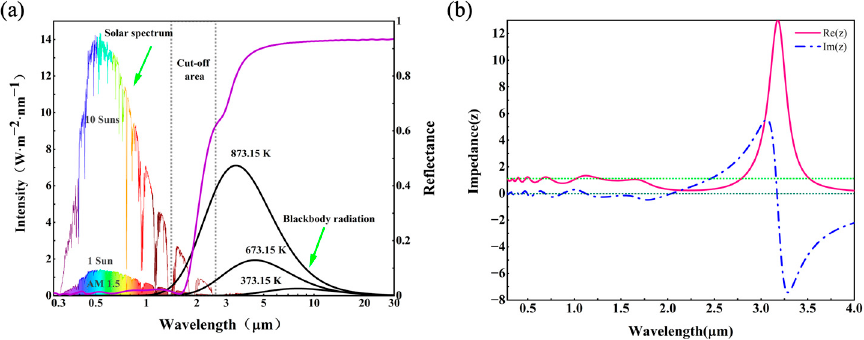
Figure 2. ( a ) Solar spectrum (AM 1.5) at 1, 10 optical concentrations, black body radiation spectrum (black line) at 373.15 K, 673.15 K, 873.15 K interspersed with reflection spectrum (purple line) of the sample and cut-off area (light grey region). ( b ) The calculated real and imaginary parts of the effective impedance for the proposed MSSA.